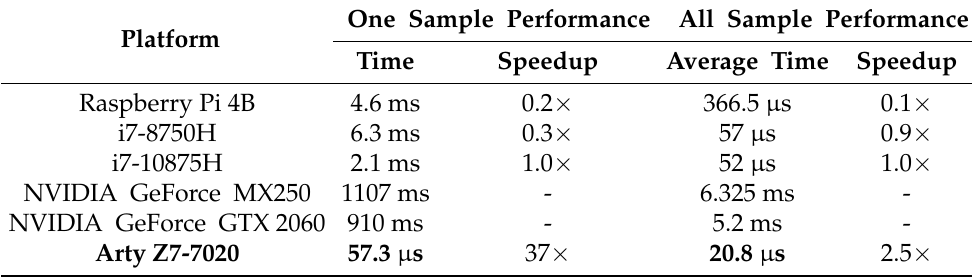
Table 8. Comparison between Raspberry Pi, CPU, GPU, and FPGA implementations for OI-DSCNN.